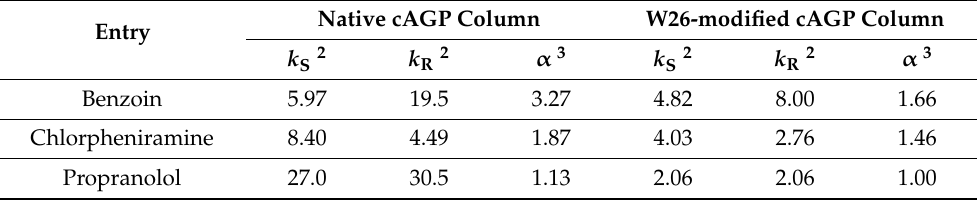
Table 1. Comparison of chiral recognition abilities of native and W26-modified cAGP columns 1 . Entry